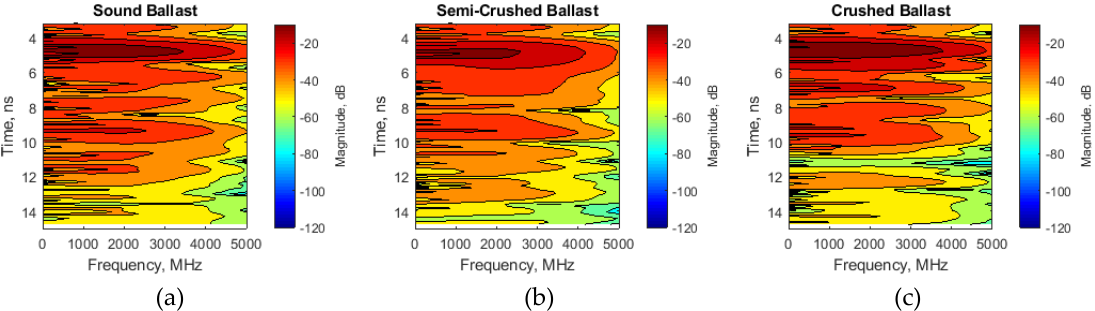
Figure 9. STFT spectra for ( a ) sound, ( b ) averagely-crushed ballast and ( c ) totally-crushed ballast, collected using the 2000 MHz antenna with 45° orientation, at the centre of the ballast slot (sleepers are excluded).